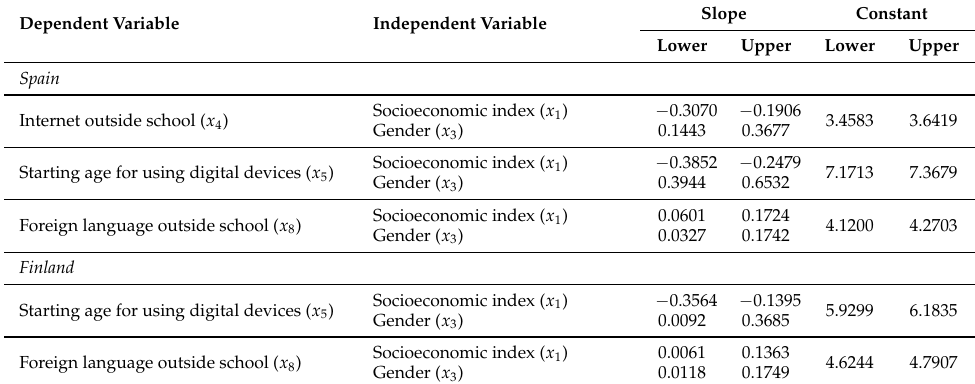
Table 6. Confidence intervals for the variables showing a statistically significant dependency (at 95%) for Spain and